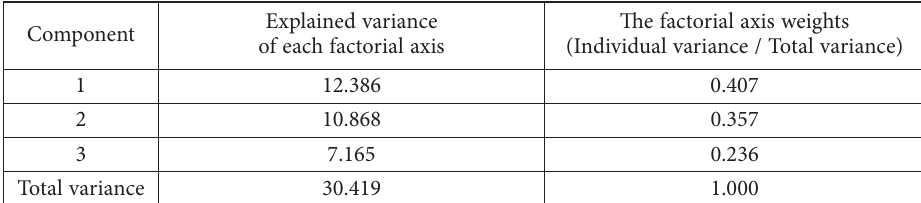
The factorial axis weights (Individual variance / Total variance)